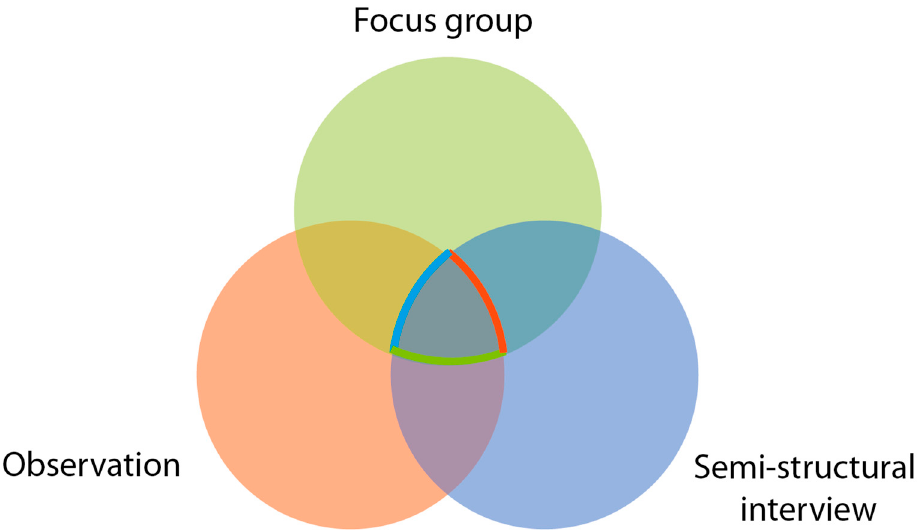
Figure 5. Triangulation of research techniques for data collection.